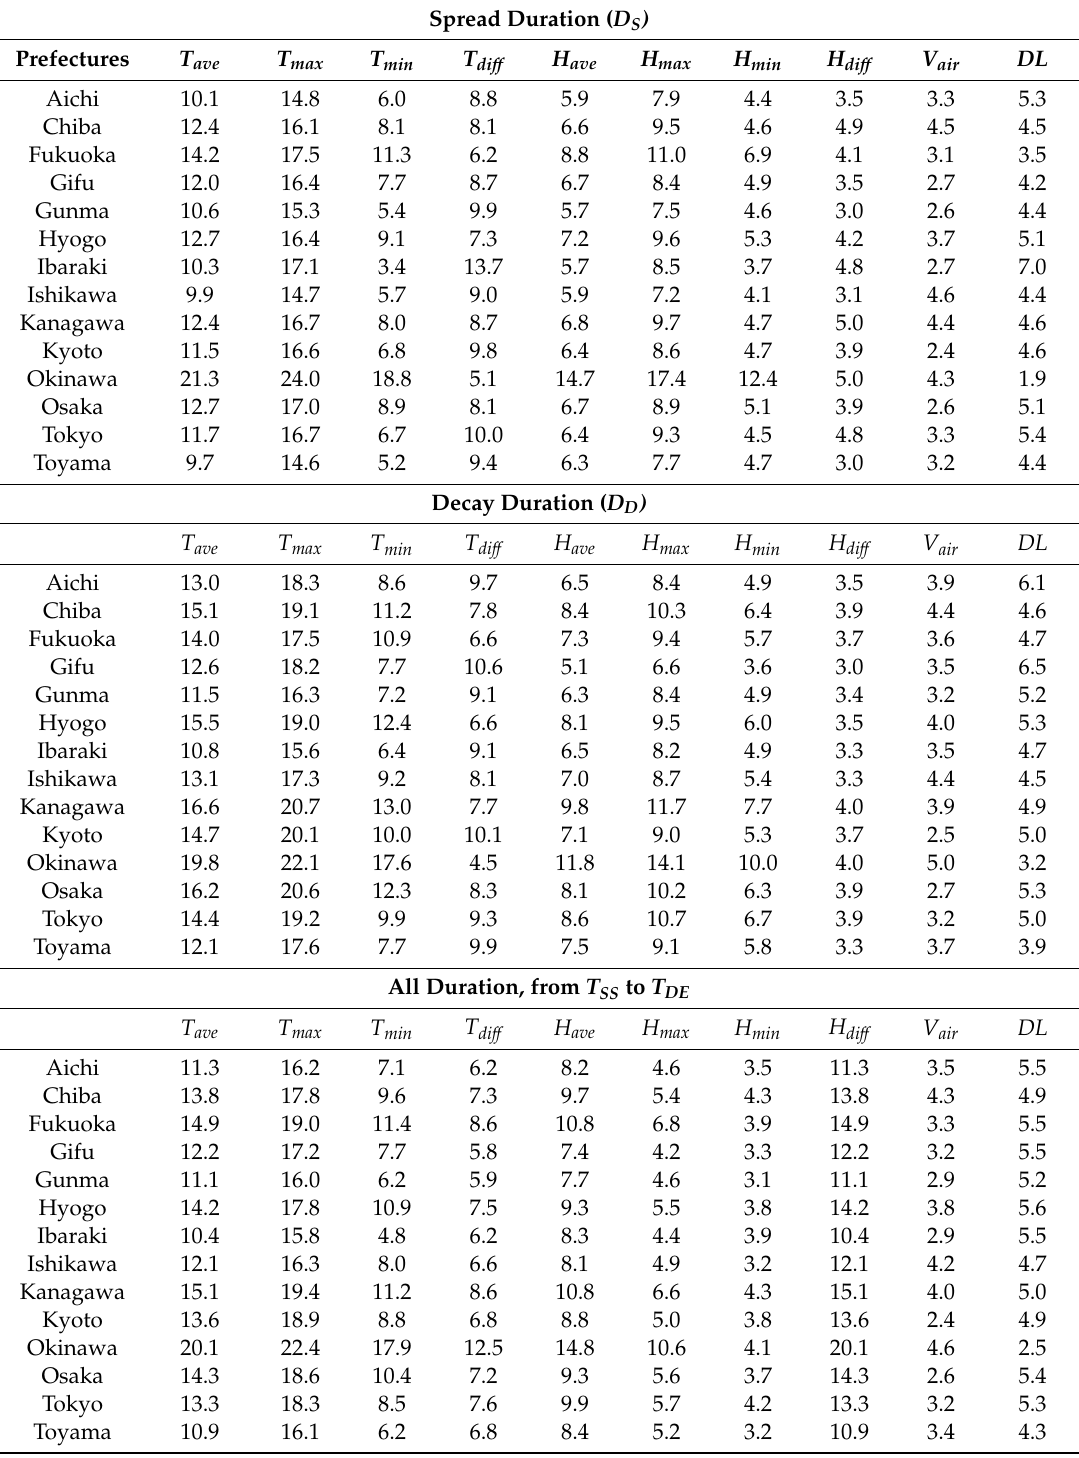
Table 3. Duration-averaged temperature ( T ), absolute humidity ( H ), wind velocity ( V air ), and daylight hours ( DL ) in each prefecture. D S and D D represent time frames during the spread and decay stages of the pandemic, respectively, as listed in Table 2. T ave , T max , and T min represent the daily average, maximum, and minimum temperatures, respectively. H ave , H max , and H min represent the daily average, maximum, and minimum absolute humidity values, respectively. V air represents the daily averaged wind